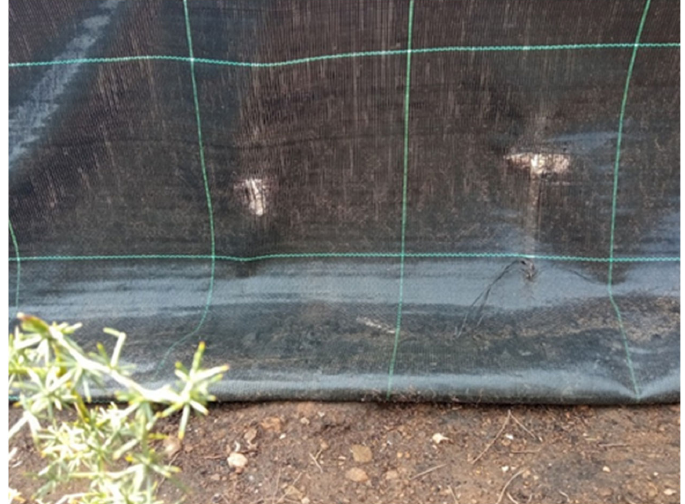
Figure 7. Large holes on the geotextile caused by wild boars.